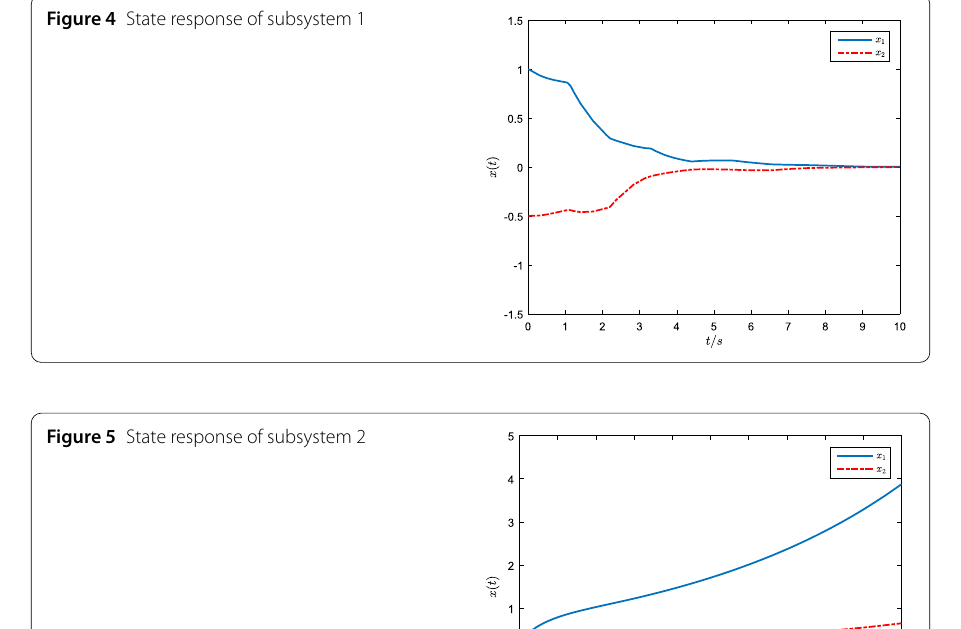
Figure 5 State response of subsystem